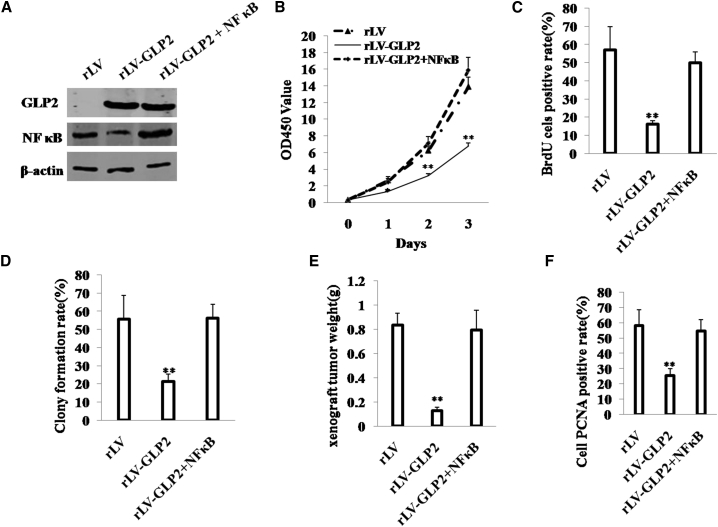
Excessive NF-κB Abrogates the Function of GLP2 in MG63 In Vitro and In Vivo(A) Western blotting with anti-GLP2, NF-κB in MG63 infected with rLV-GLP2, rLV-GLP2 plus pcDNA3-NF-κB or pLV. β-actin was used as an internal control. (B) Cell proliferation assay was performed in 96-well format using the CCK8 cells proliferation kit to determine the cell viability as described by the manufacturer. Each sample was assayed in triplicates for 3 days consecutively. Cell growth curve was based on the corresponding the relative values of OD450 and each point represents the mean of three independent samples. Data are means of value from three independent experiments (error bar ± SEM; **p < 0.01 and *p < 0.05). (C) Cell BrdU assay. Data are means of value from three independent experiment (error bar ± SEM; **p < 0.01). (D) Cell plate colony formation ability assay. Data are means of value from three independent experiment (error bar ± SEM; **p < 0.01). (E) The xenograft tumors from BALB/c nude mouse injected with MG63 cells infected with rLV, rLV-GLP2, rLV-GLP2 plus pcDNA3-NF-κB subcutaneously at armpit. The xenograft tumors weight (gram) in the three groups. Data were means of value from six BALB/c mice (mean ± SEM; n = 6; **p < 0.01). (F) A portion of each xenograft tumor was fixed in 4% formaldehyde and embedded in paraffin, and the micrometers of sections (4 μm) were made for PCNA staining (original magnification × 100). **p < 0.01.